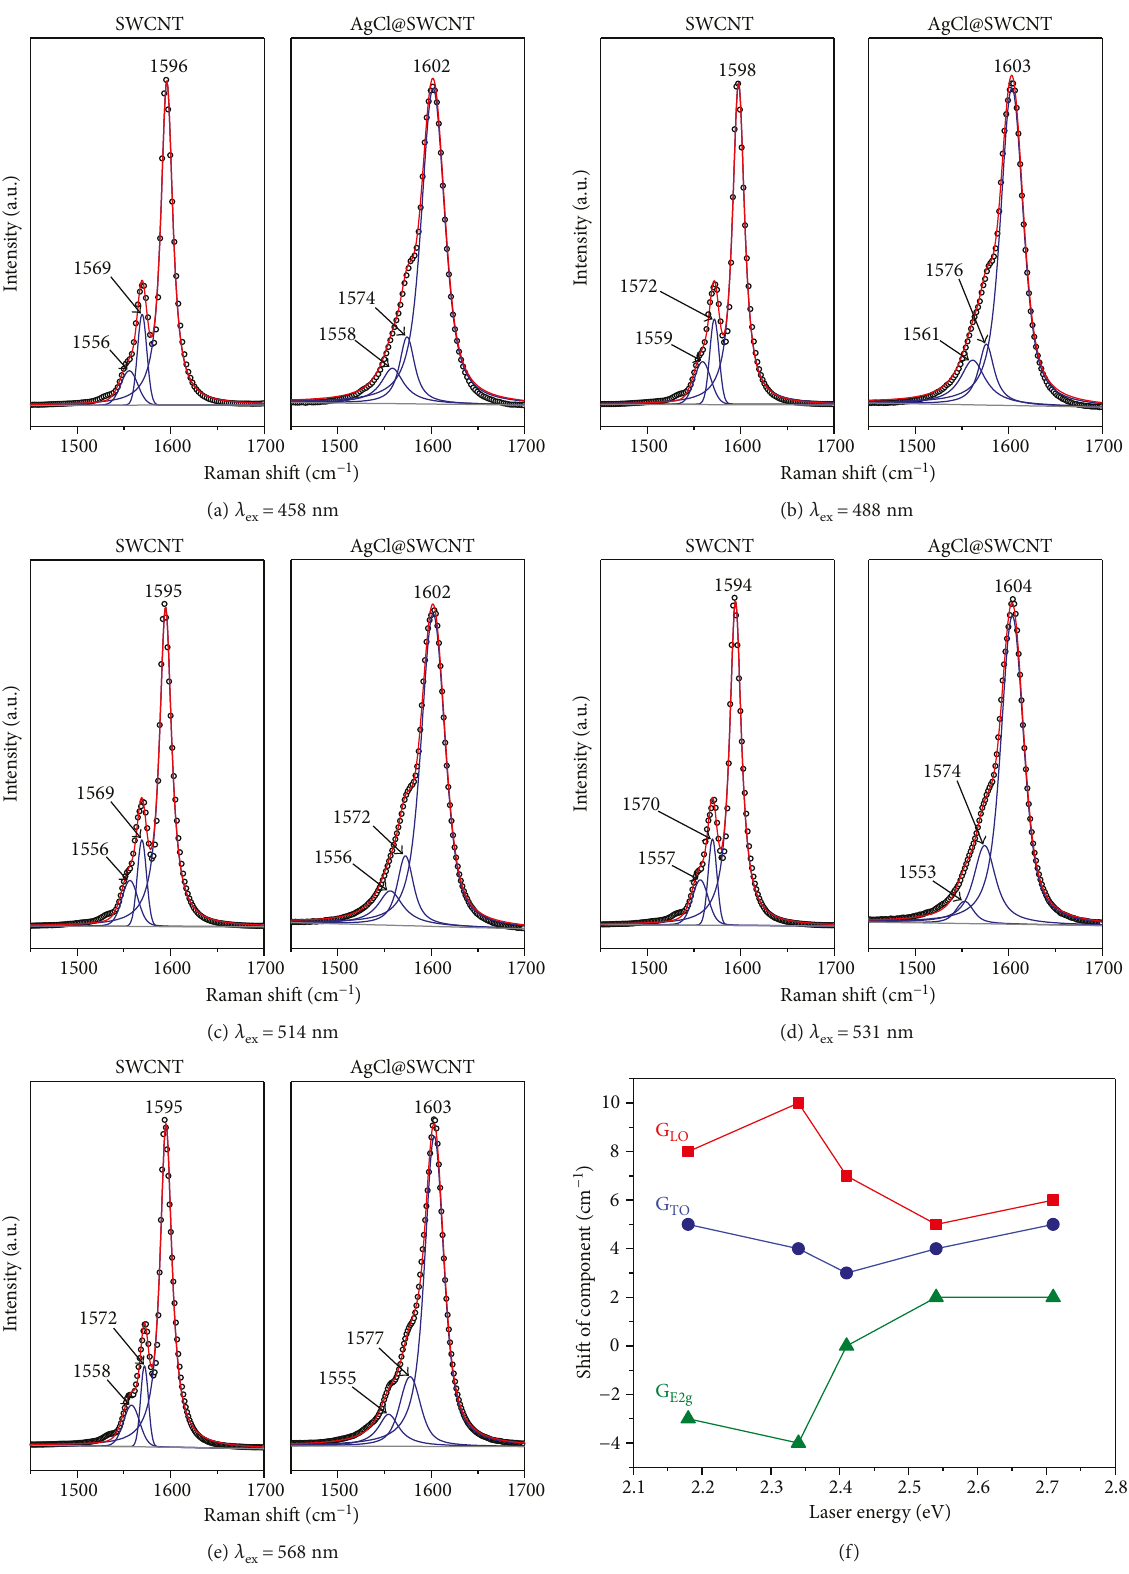
Figure 4: (a – e) The G-bands of Raman spectra of the pristine and AgCl- fi lled SWCNTs fi tted with individual components G G . The positions of the maxima of components are denoted. (f) The shift of components of the G-band relative to the positions of the LO pristine SWCNTs plotted versus laser